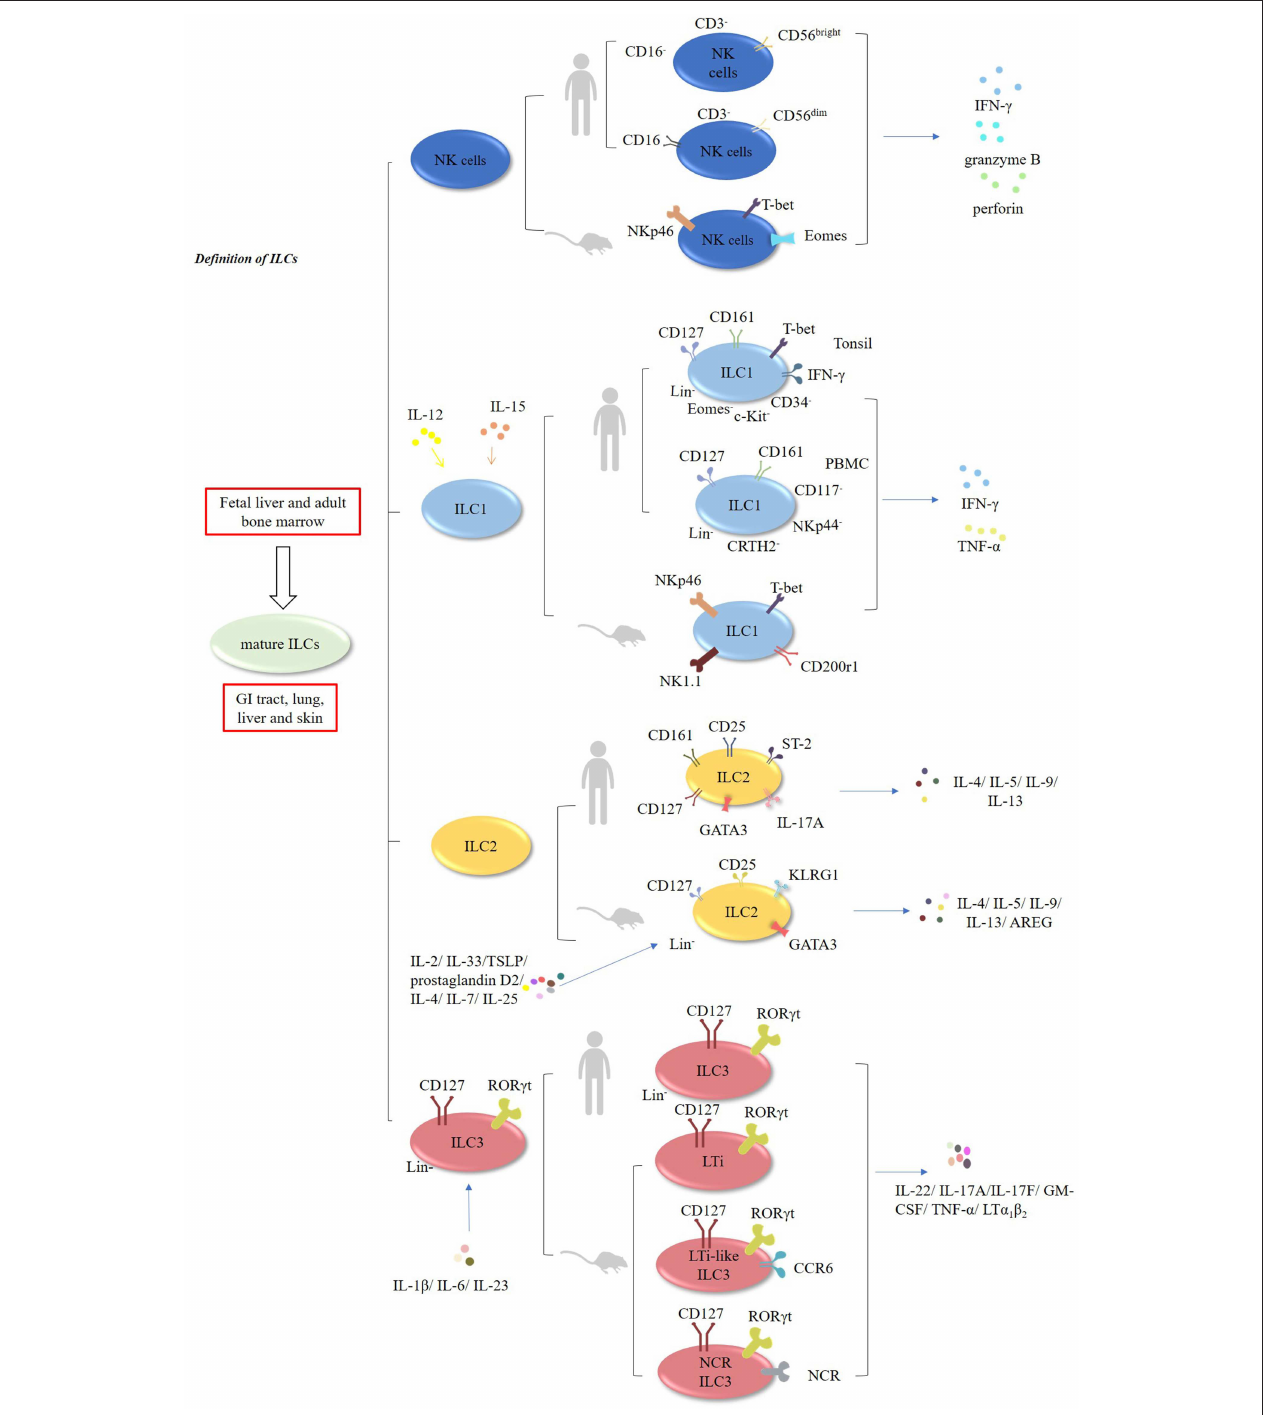
FIGURE 1 | Characteristic of ILCs. ILCs encompass NK, ILC1, ILC2, and ILC3 cells. Murine and human NK cells can secrete IFN- γ , granzyme B, and perforin. In humans, NK cells have two main subsets: CD3 − CD56 bright CD16 − and CD3 − CD56 dim CD16 + cells. ILC1 cells can respond to IL-12 and IL-15, and subsequently produce IFN- γ and TNF- α . In humans, CD127 + CD161 + CD34 − c-Kit − T-bet + Eomes − IFN- γ + ILC1 cells are enriched in the tonsils. Additionally, Lin − CD127 + CD161 + CD117 − NKp44 − CRTH2 − ILC1 cells have been found in the human PBMCs. In mice, ILC2 cells are Lin − CD127 + CD25 + KLRG1 + GATA3 high cells which are responsive to IL-2, IL-4, IL-7, IL-25, IL-33, TSLP, and prostaglandin D2, and subsequently produce multiple effector cytokines. In humans, ILC2 cells express GATA3, CD127, CD161, CD25, ST-2, IL-17A, and CRTH2. Both murine and human ILC3 cells are Lin − CD127 + ROR γ t + . They are responsive to IL-1 β , IL-6, and IL-23, and produce IL-22, IL-17A, IL-17F, GM-CSF, TNF- α , and LT α 1 β 2 .